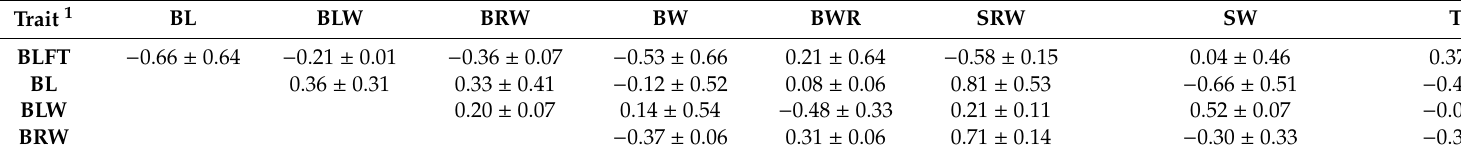
Table 13. Genetic correlations among novel